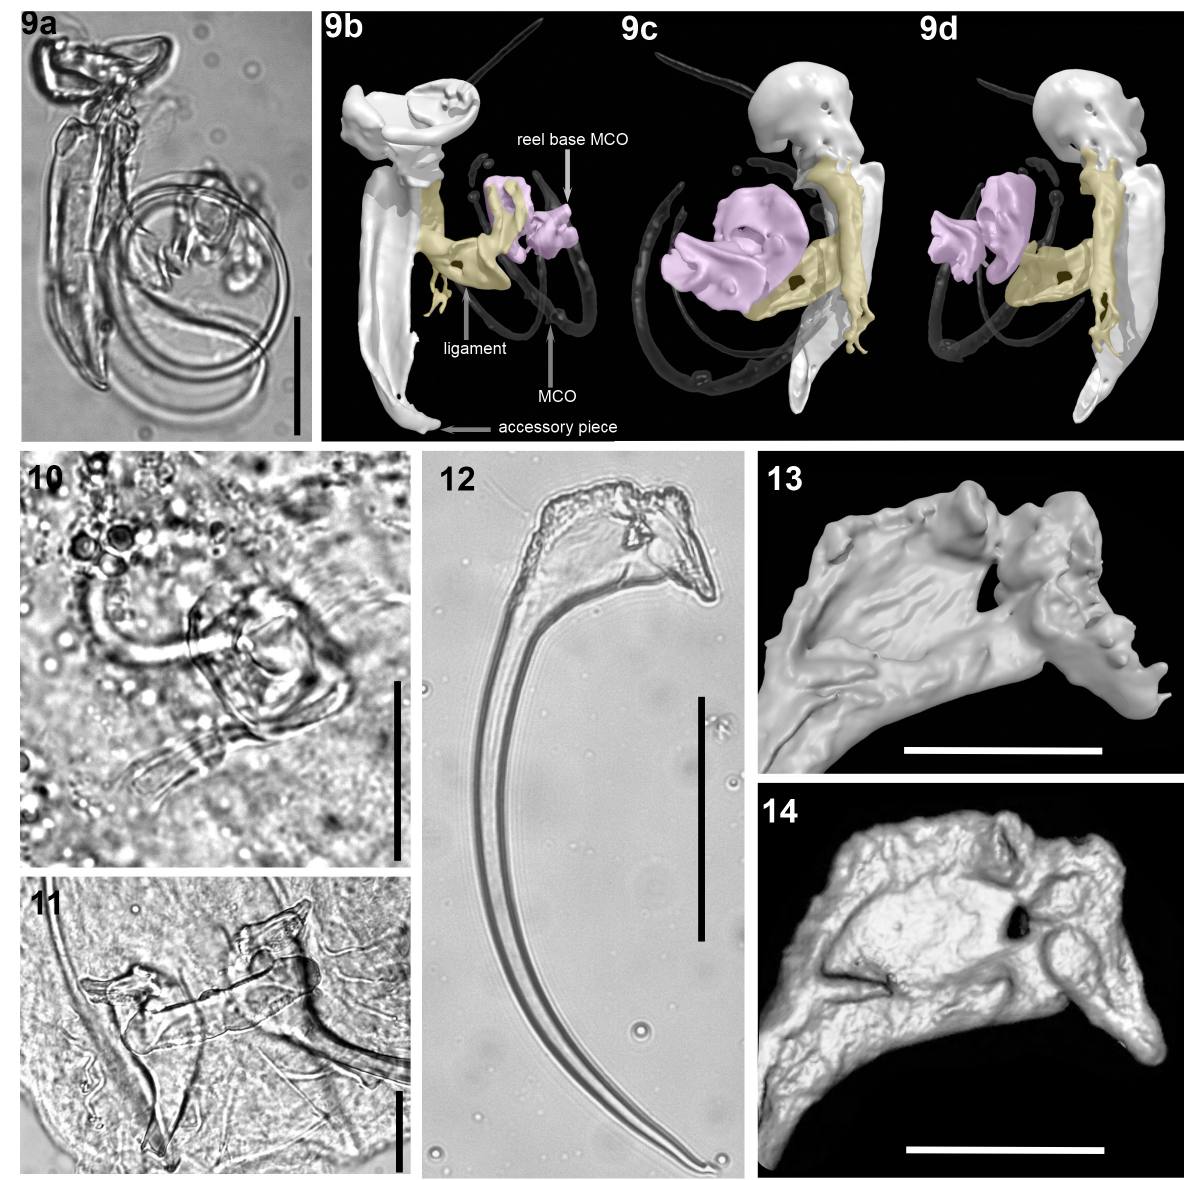
Figures 9 - 14 - Rhinoxenus argentinensis n. sp. 9. Male copulatory complex, 9a. Microscope photograph, 9b . 3D-reconstruction (ventral view), 9c . 3D-reconstruction (dorsolateral view), 9d . 3D-reconstruction (dorsal view); 10 . Vagina (ventral view); 11 . Aptoral sclerites (ventral view); 12 . Ventral anchor (ventral view, microscope photograph); 13 . Base of ventral anchor -3D-reconstruction (deconvolved stacks); 14 . Base of ventral anchor -3D-reconstruction (brightness and contrast adjusted). Scale bars: 9-11b-13= 20 µm; 11a = 50